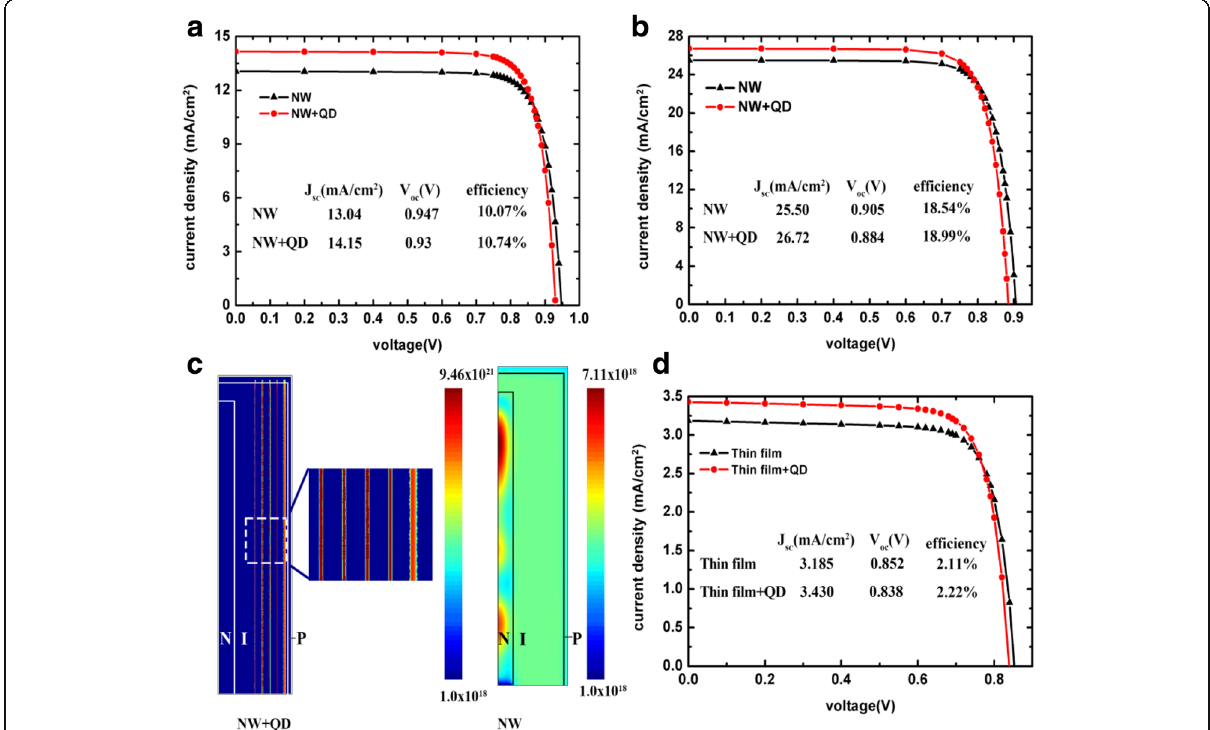
Fig. 5 a The I - V characteristics of short NW and NW/QD hybrid solar cells. b The I - V characteristics of long NW and NW/QD hybrid solar cells. c Half of the vertical cross section of radiative recombination rates of short NW and NW/QD hybrid solar cells. d The I - V characteristics of thin-film and thin-film/QD hybrid solar